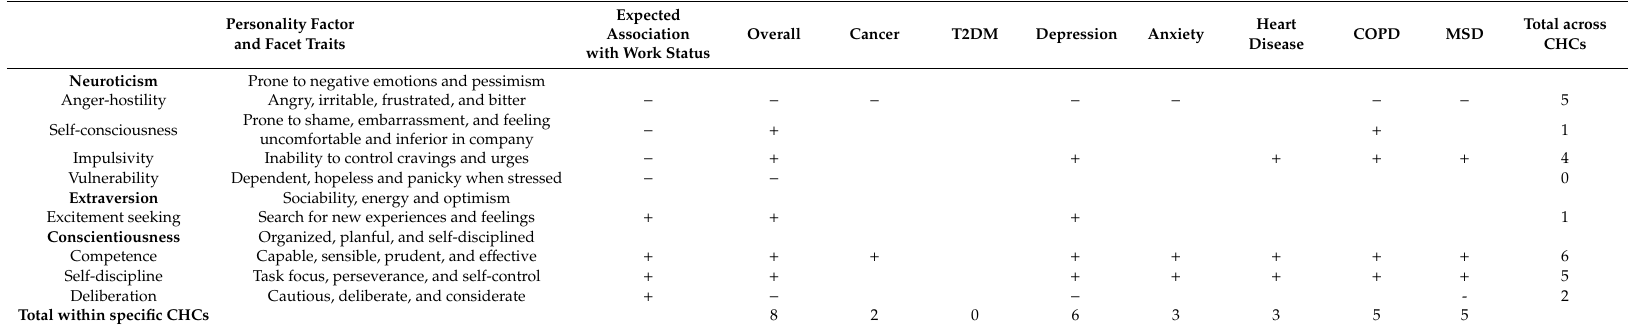
Table 5. Overview of the findings in relation to the a priori